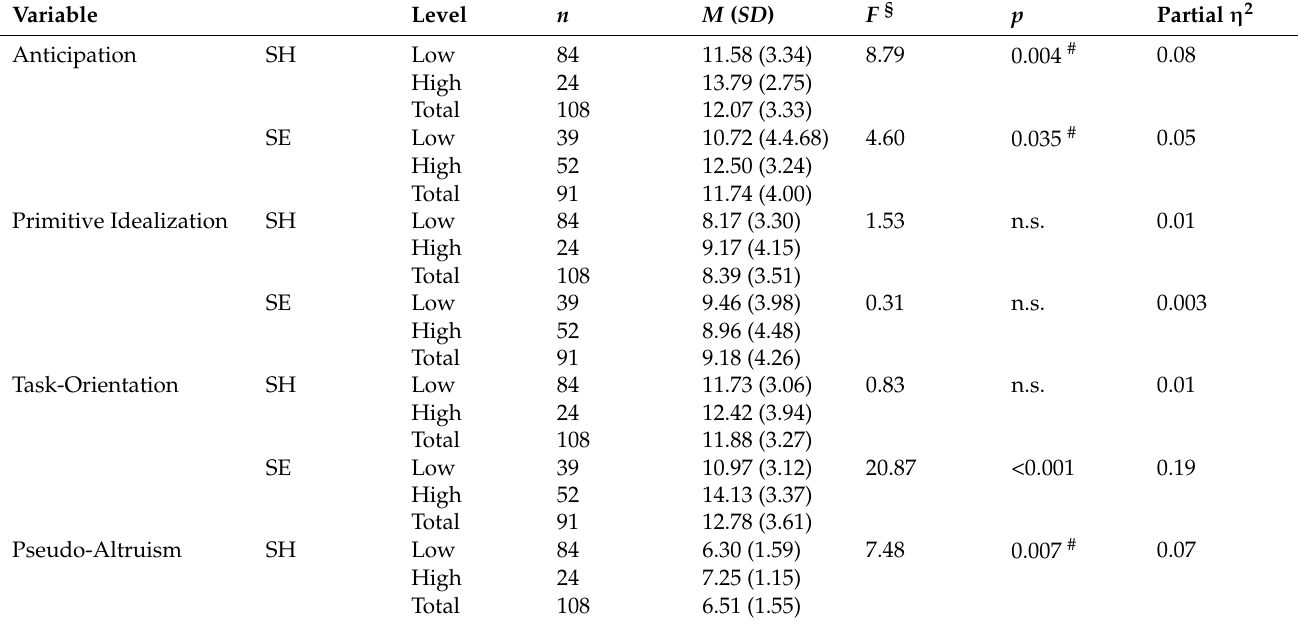
Table 6. Follow-up ANOVAs. DSQ scales by low and high Studyholism (SH) and Study Engagement (SE). Adaptive